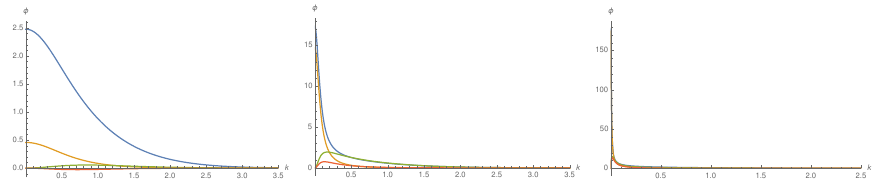
(in blue), φ − (in yellow), 0 0